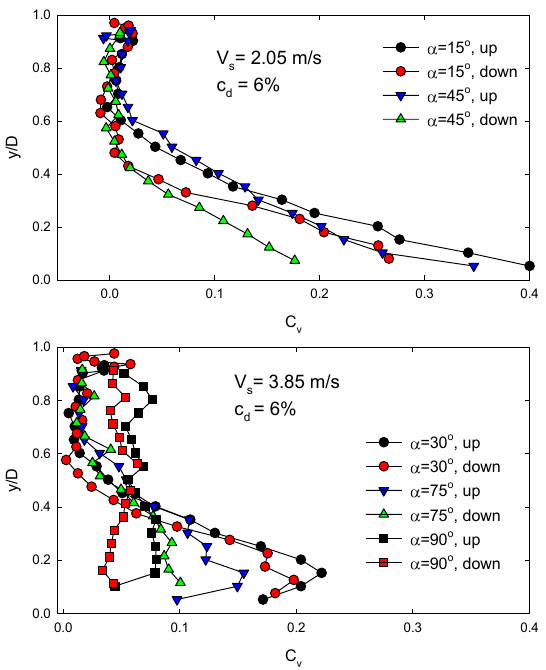
Fig. 8. Effect of the ascending and descending flow on local concentration c